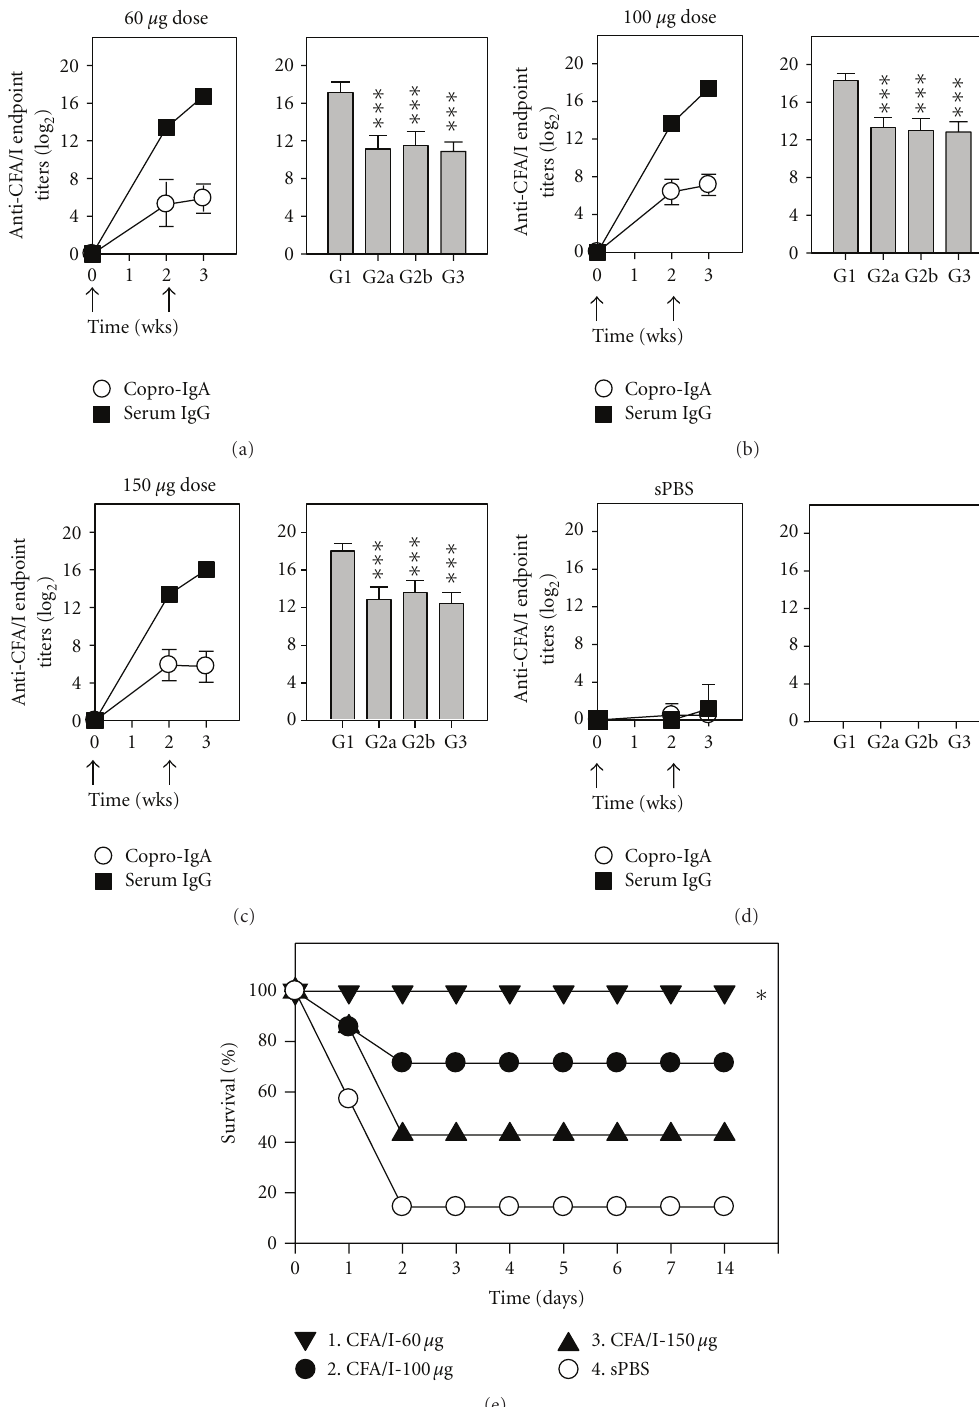
Figure 1: Evaluation of the protective immunity of the detoxed CFA/I fimbriae. (a)–(d) Endpoint Ab titers were induced to detoxed CFA/I fimbriae. BALB/c mice (7/group) were i.m. immunized with (a) 60, (b) 100, (c) 150, or (d) 0 µ g CFA/I fimbriae on days 0 and 14. Serum IgG and mucosal IgA anti-CFA/I fimbriae endpoint Ab titers were measured at 0, 2, and 3-wk postprimary immunization. IgG subclass responses were determined at wk 3, and ∗ P < 0 . 05, ∗∗ P < 0 . 01, and ∗∗∗ P < 0 . 001 versus IgG1 titers. (e) Assessment of the protective e ffi cacy against i.p. ETEC challenge was determined. CFA/I fimbriae-immunized mice (a)–(c) and sPBS-dosed mice (d) were i.p. challenged with 5 × 10 7 CFUs of wt ETEC H10407 at 4-wk postprimary immunization. Mouse survival rates were observed for 14 days. The survival rates of 60 µ g, 100 µ g, and 150 µ g CFA/I fimbriae-immunized mice were 100% (7/7), 71.4% (5/7), and 42.9% (3/7), respectively, versus 14.3% (1/7) for sPBS-dosed mice. Survival fractions obtained from vaccinated mice were compared to sPBS-dosed mice, and significance was determined: ∗ P < 0 .